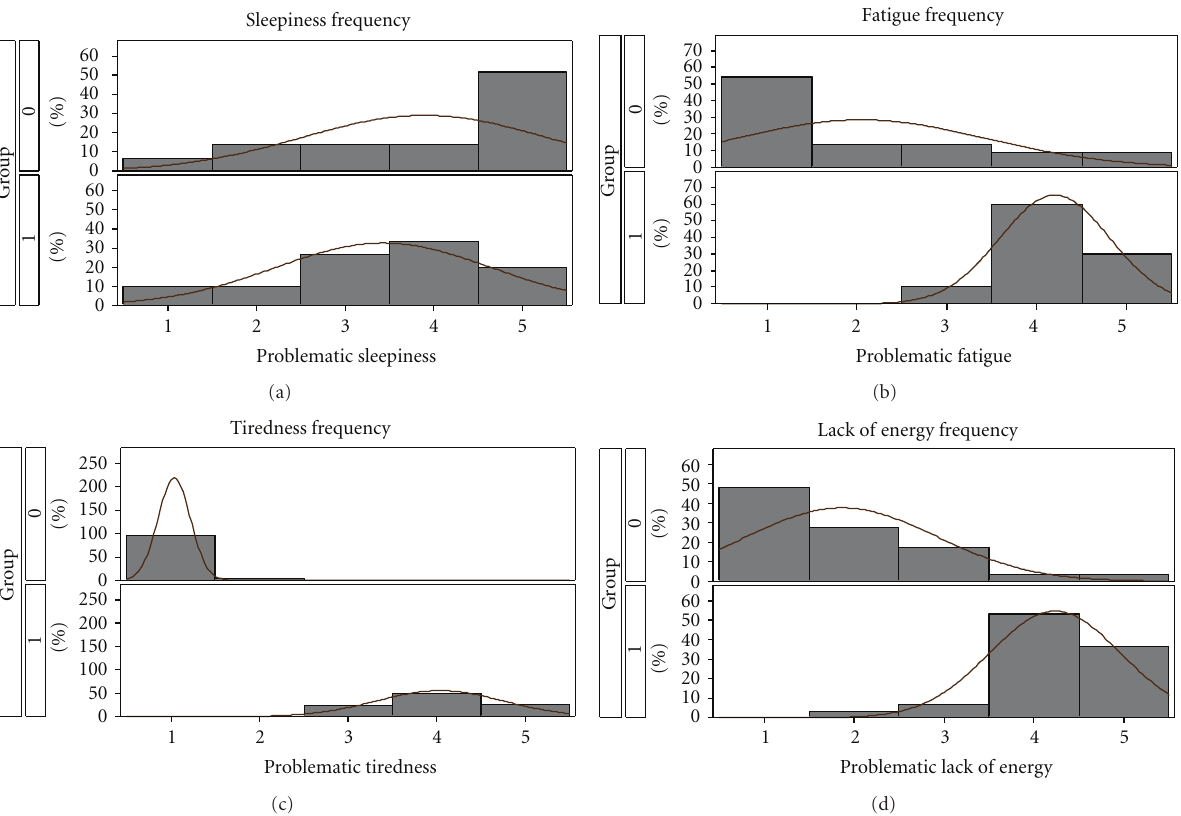
Figure 1: Frequencies of Likert responses for problematic sleepiness (a), fatigue (b), tiredness (c), and lack of energy (d) among MS patients (group 1) and matched controls (group 0). 1 = “never;” 2 = “seldom;” 3 = “occasionally;” 4 = “often;” and 5 = “almost